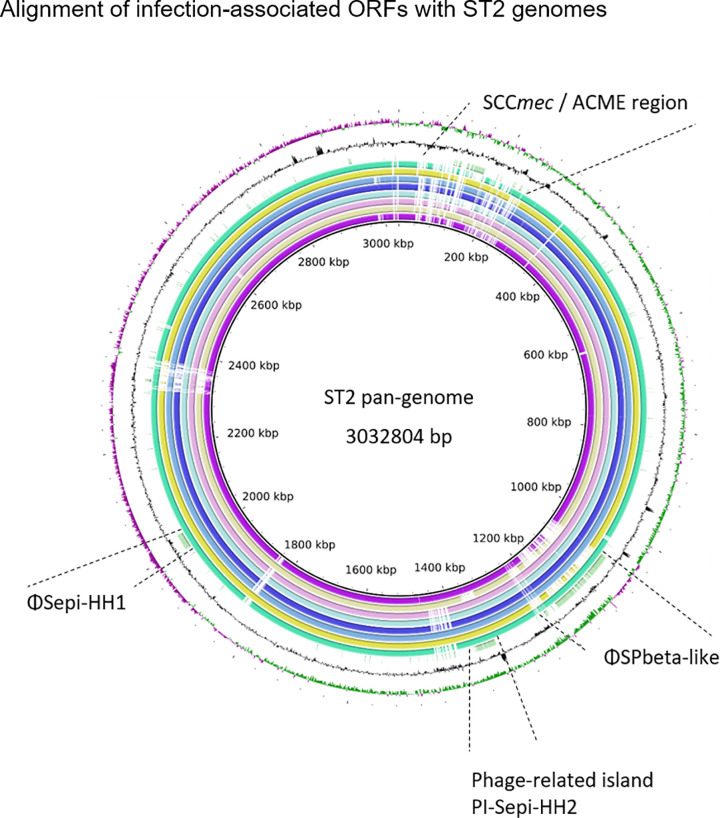
Alignment of infection-associated genes against ST2 pan-genome.From innermost circle to outermost: HD05 (purple), HD12 (lime), HD21 (pink), HD25 (light blue), HD31 (dark blue), HD46 (blue), HD47 (yellow), HD99 (turquois) and significantly associated genes (green). GC-content (black), GC-skew (+) green, GC-skew (-) purple.